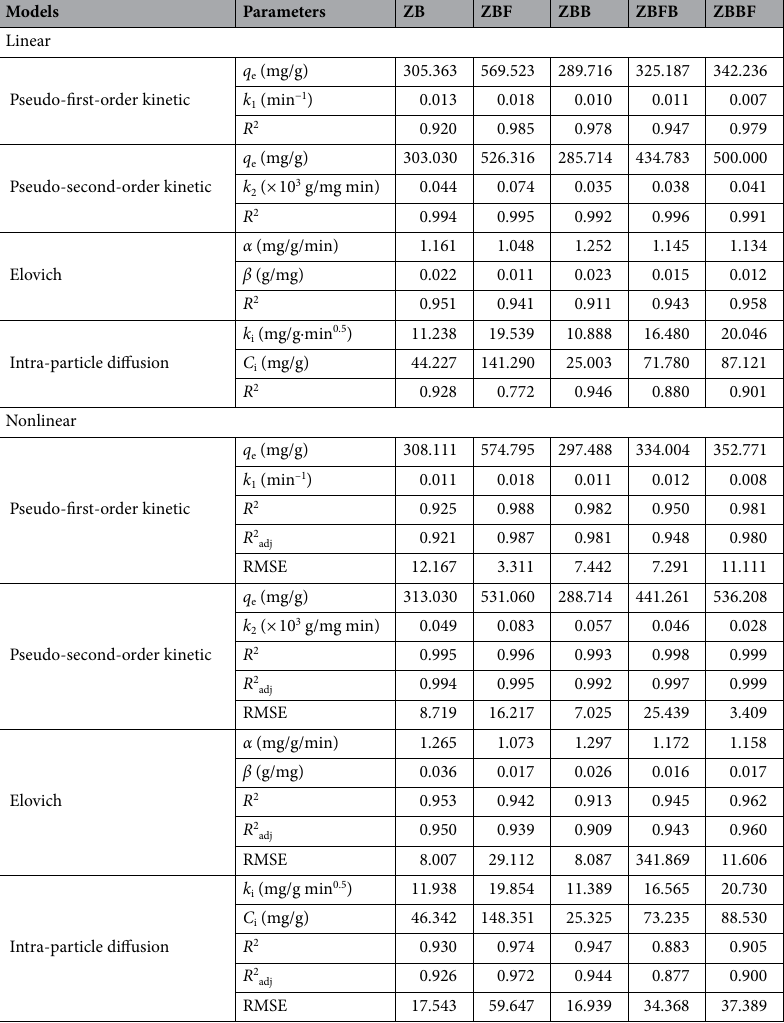
Table 5. The comparison of linear and nonlinear kinetic parameters for lead adsorptions on zeolite A sugarcane bagasse fly ash powder (ZB), zeolite A sugarcane bagasse fly ash powder mixed iron(III) oxide- hydroxide (ZBF), zeolite A sugarcane bagasse fly ash beads (ZBB), zeolite A sugarcane bagasse fly ash powder mixed iron(III) oxide-hydroxide beads (ZBFB), and zeolite A sugarcane bagasse fly ash beads coated iron(III) oxide-hydroxide